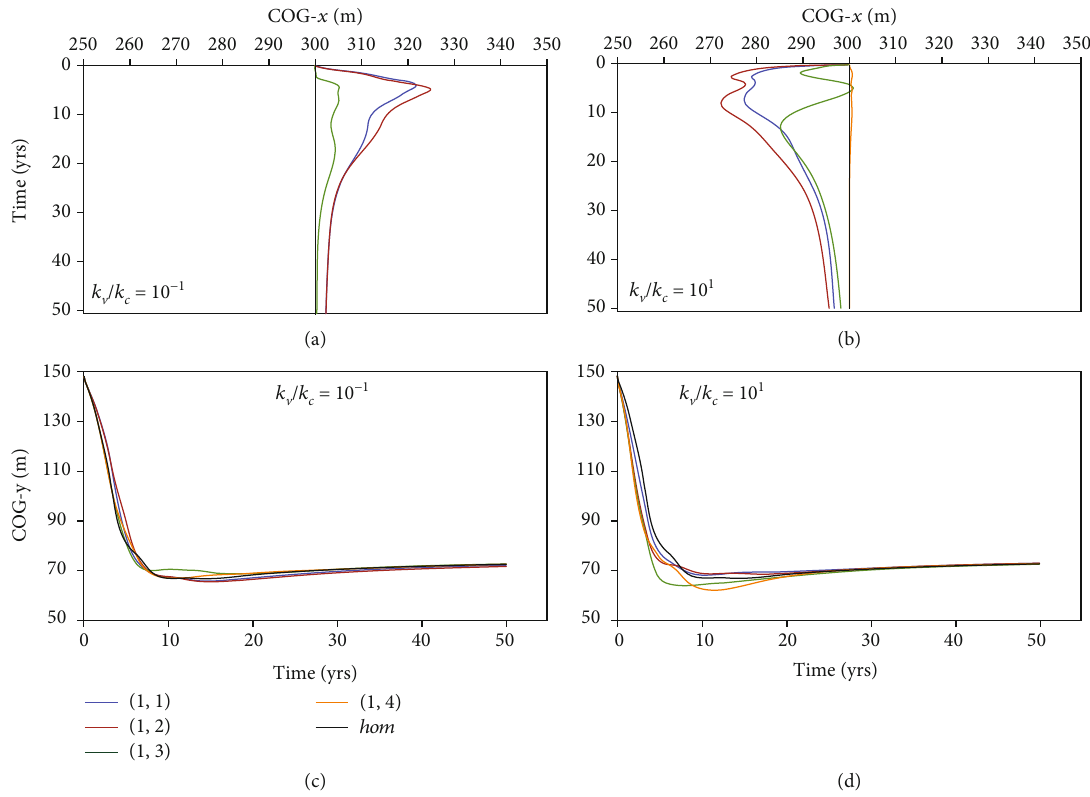
Figure 9: The calculated horizontal and vertical gravity center of the salt mass (COG- x and COG- y ) in the domain with (a, c) low-permeability regions ( k